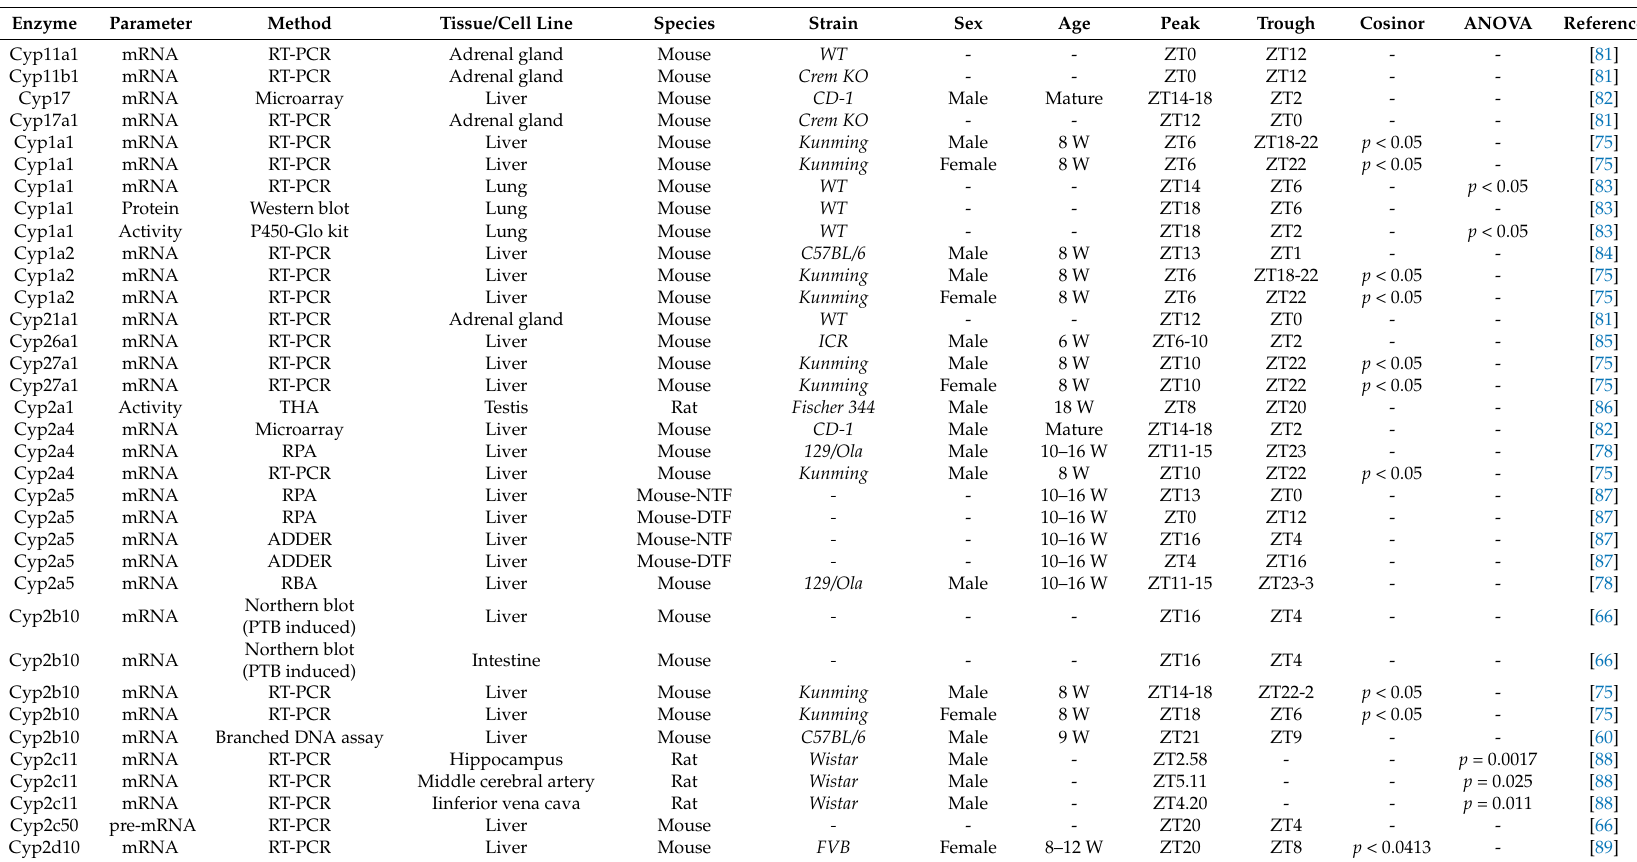
Table 1. This table summarizes the amount and activities of CYP 450 level at both molecular and biochemical levels in various circadian times in mammals along with rhythm parameters from different